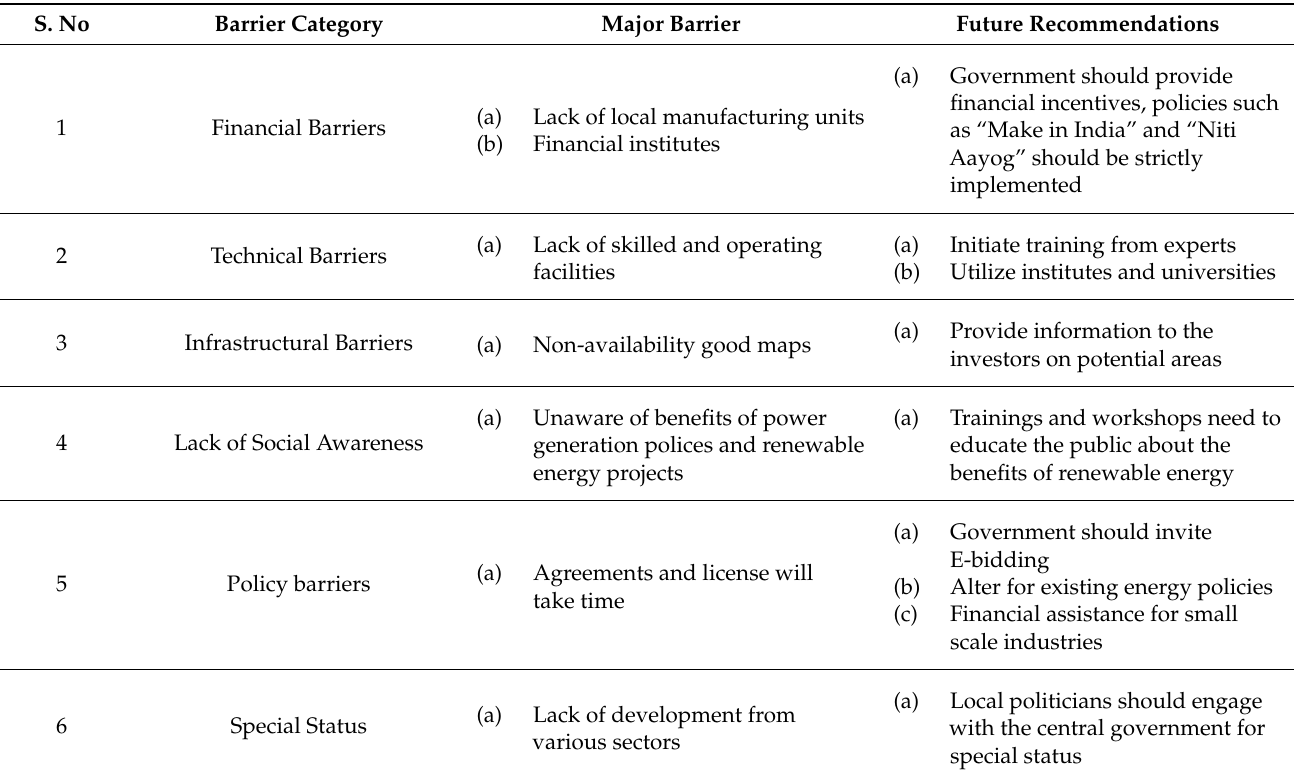
Table 7. Summarized barriers in the development of CSP technologies in India and list of recommen-